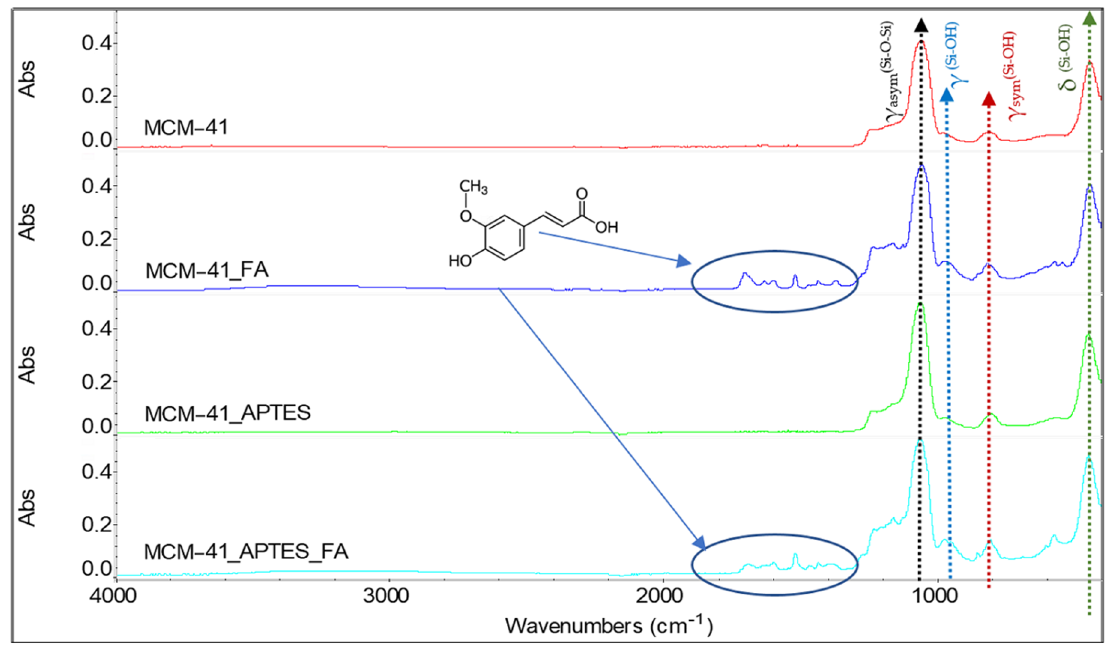
Figure 4. FTIR spectra and band assignments for the samples MCM-41, MCM-41_FA, MCM- 41_APTES and MCM-41_APTES_FA.